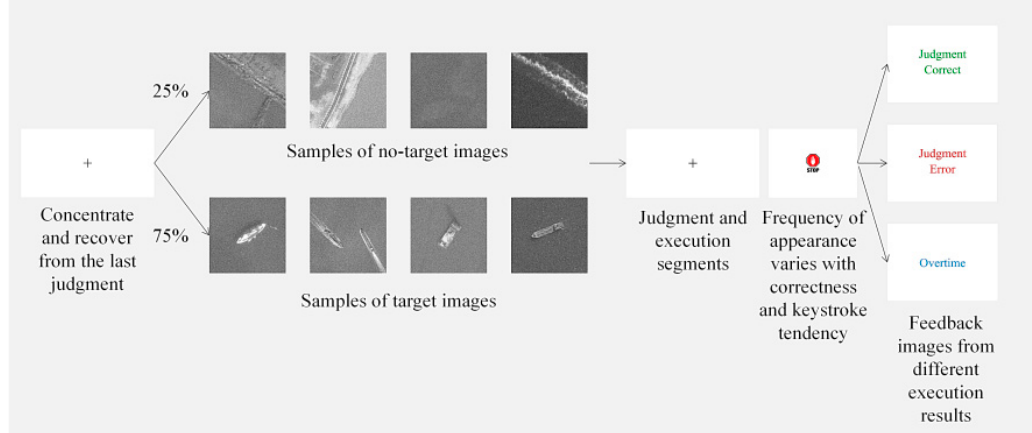
Figure 3. The process of each trial of experiments.